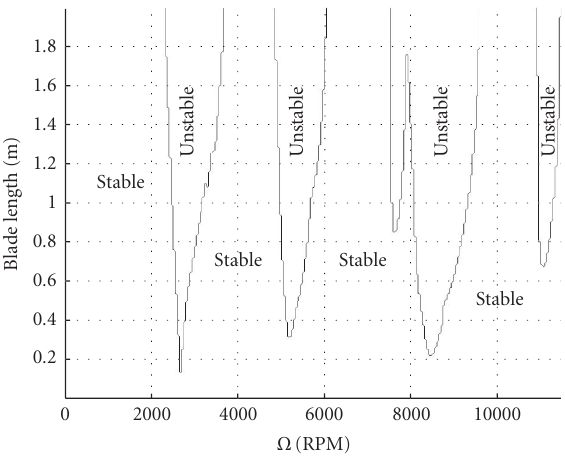
Figure 12: Stability map of a two-rigid-bladed rotor as a function of its blade length and its rotational speed.